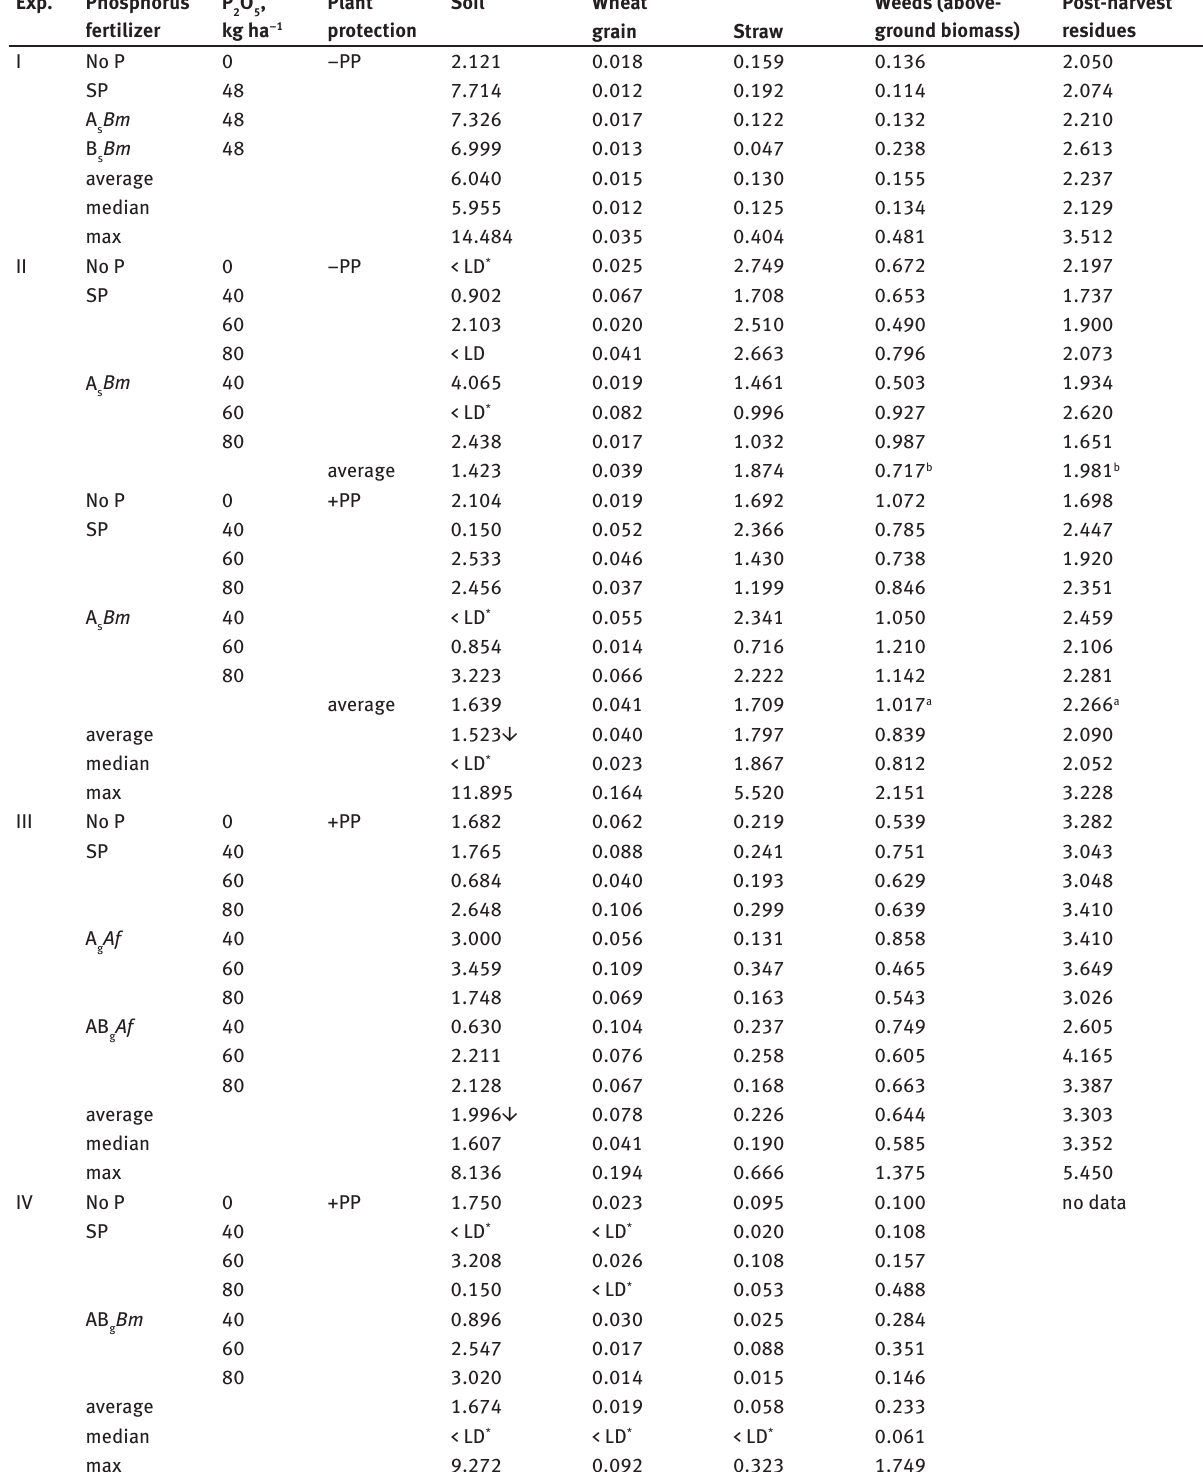
Table 8: Lead content in soil and plant biomass from wheat field, mg kg –1 (dry matter).